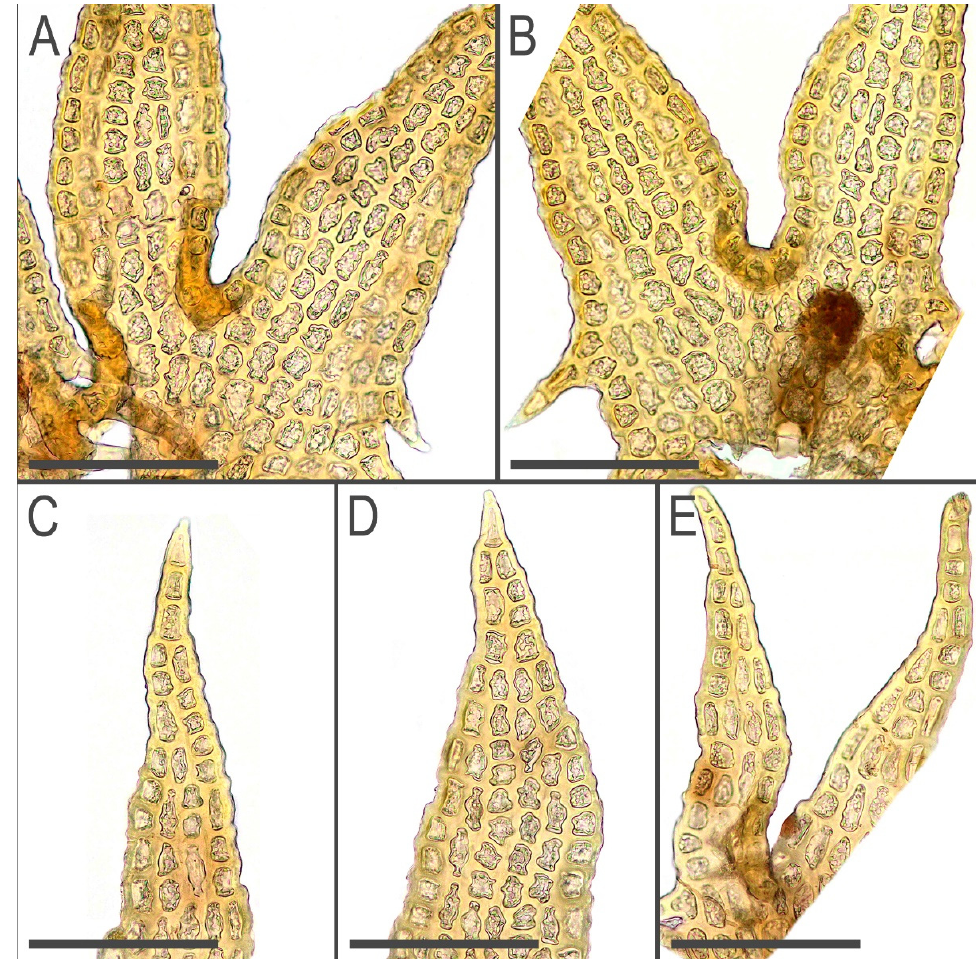
Figure 5. Tetralophozia sibirica Vilnet et Bakalin: A , B —leaf sinus area; C – E —leaf lobe apex. Scales: A – E —100 µm. All from holotype.